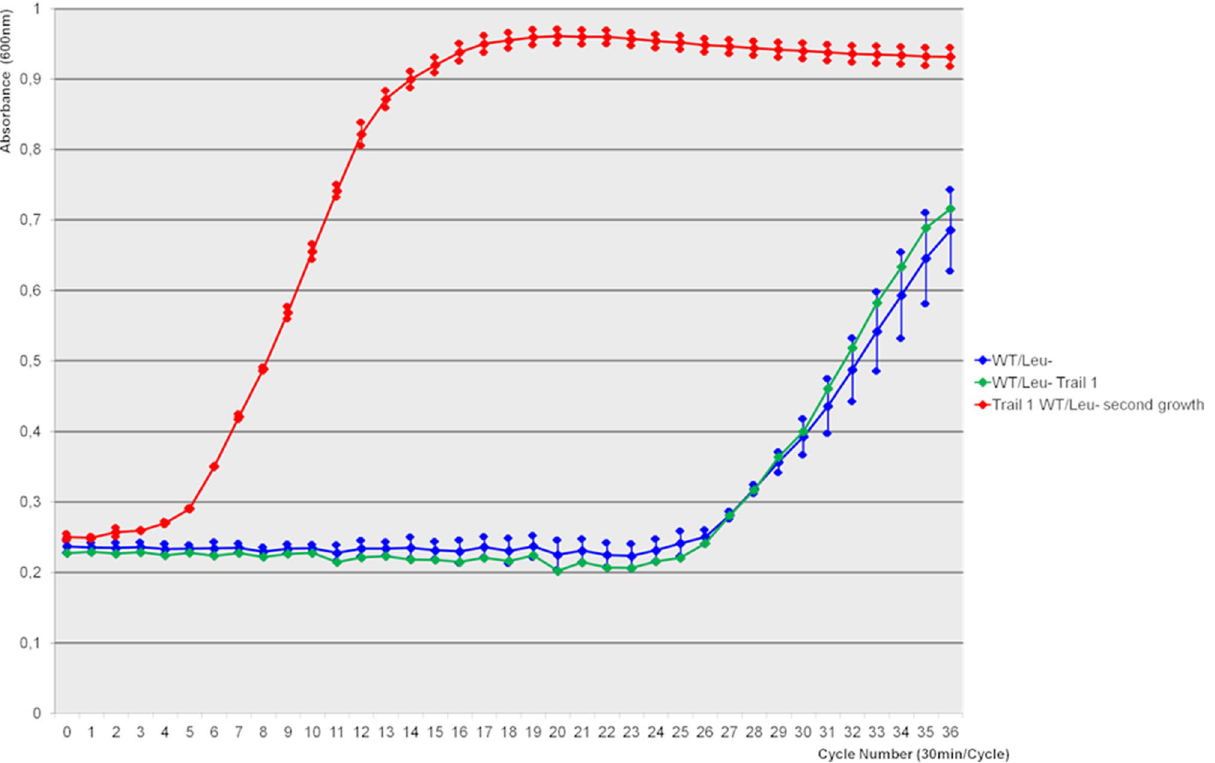
Figure 3. Secondary growth: The green curve represents the first growth trial of the WT under leucine deprivation. When growing the bacteria for the first time a strong increase of growth at the end of the experiment can be found. Blue shows the respective mean values. The red curve shows the growth of the same bacteria like in the green curve in a second growth experiment. Here the bacteria show a strong growth from the beginning suggesting that an adaptational process took place. In the supplemental material this effect is shown for different mutant strains in different AA deprived